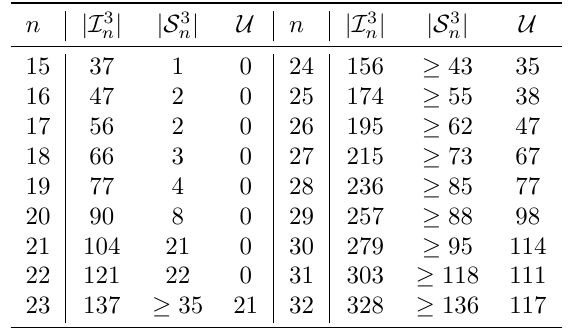
Table 2: Comparison of number of configurations for 3-round trails. Here U denotes the number of remaining cases left to solve for completing the search space for a given n .